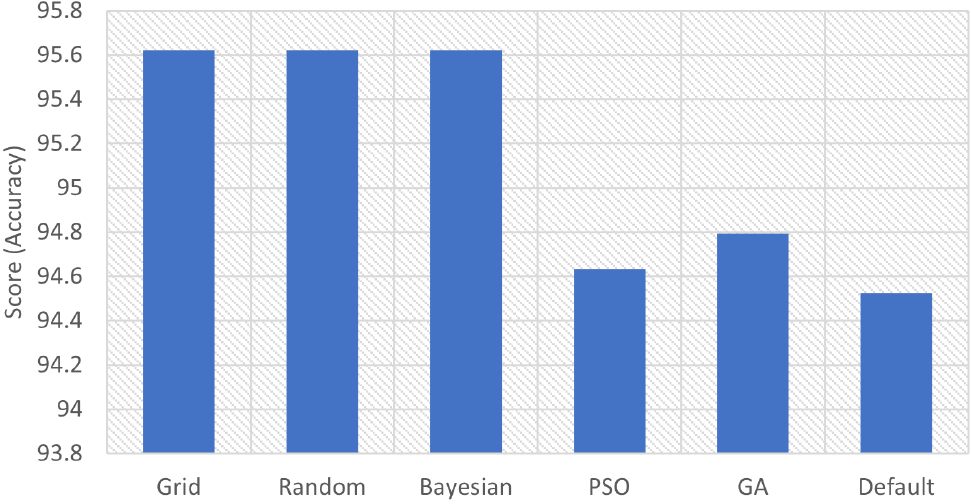
Figure 15. Hyperparameter tuning techniques versus score for Support Vector Classifier (SVC).